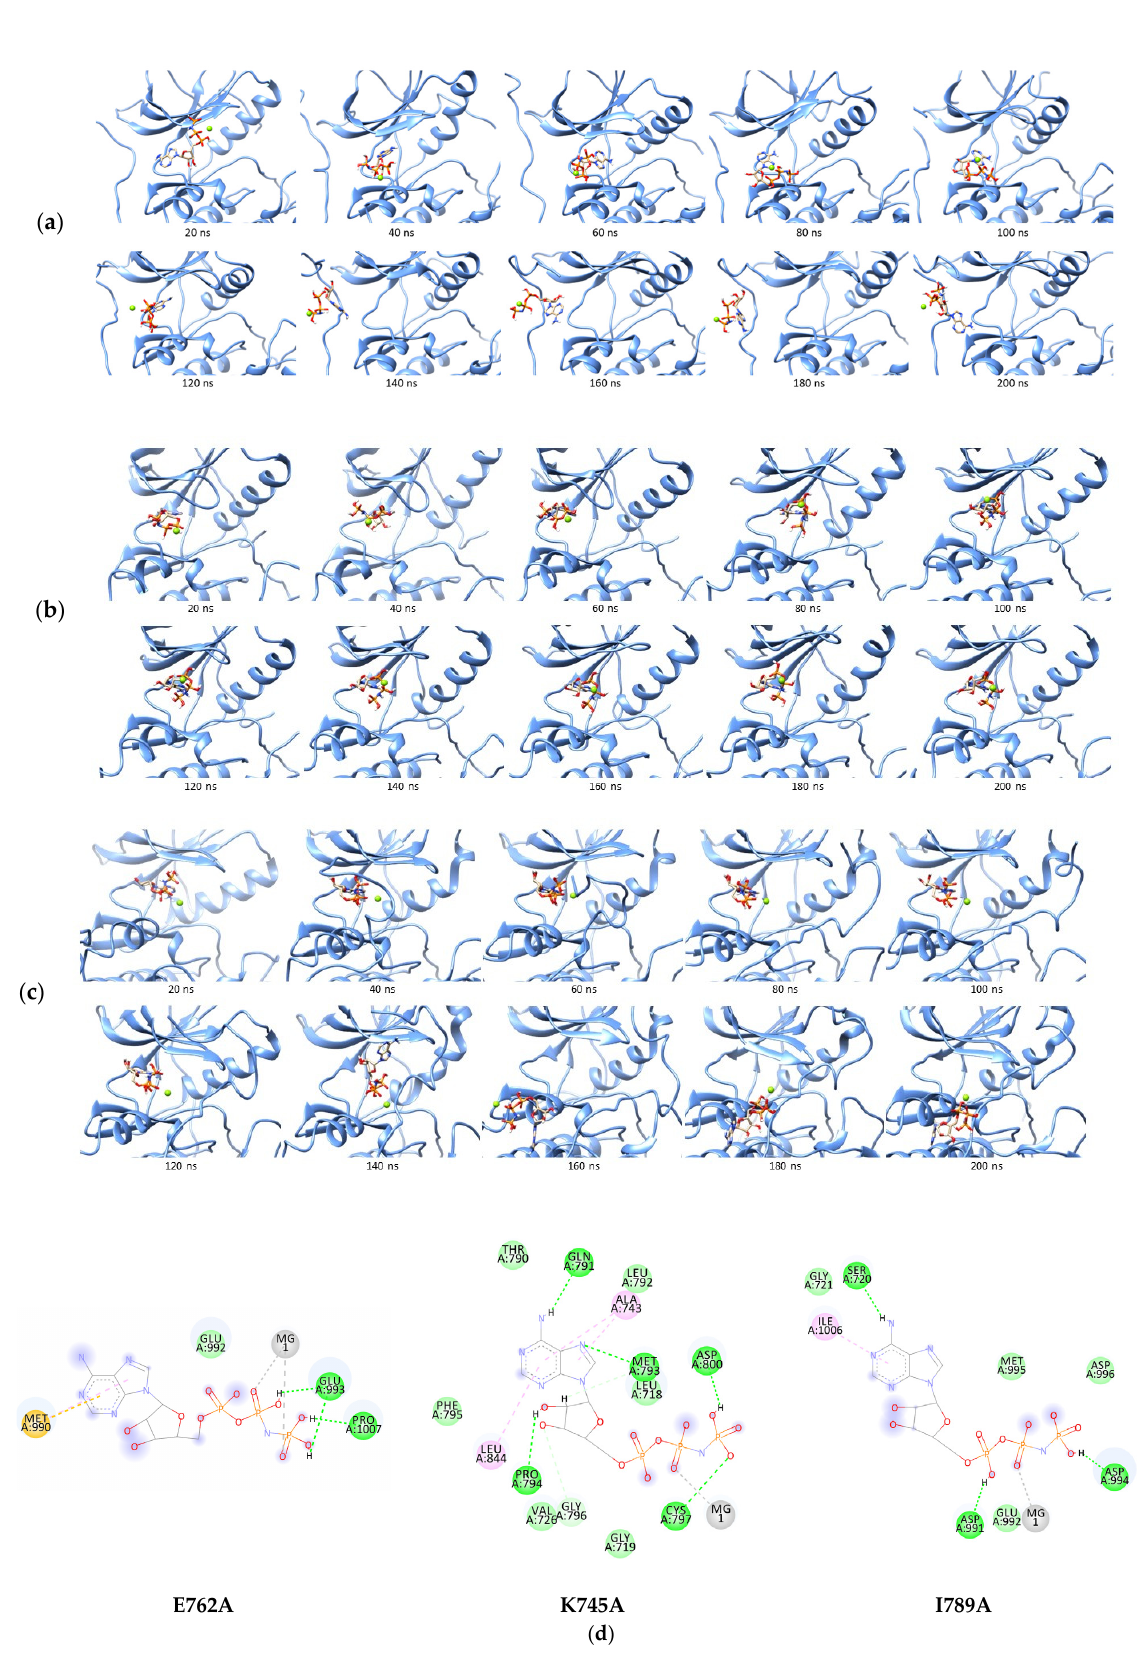
E762A K745A I789A ( d ) Figure 5. Trajectories of ANP during 200 ns simulation in the binding site of E762A ( a ), K745A ( b ), Figure 5. Trajectories of ANP during 200 ns simulation in the binding site of E762A ( a ), K745A ( b ), Figure 5. Trajectories of ANP during 200 ns simulation in the binding site of E762A ( a ), K745A ( b ), Figure 5. Trajectories of ANP during 200 ns simulation in the binding site of E762A ( a ), K745A ( b ), Figure 5. Trajectories of ANP during 200 ns simulation in the binding site of E762A ( a ), K745A ( b ), Figure 5. Trajectories of ANP during 200 ns simulation in the binding site of E762A ( a ), K745A ( b ), Figure 5. Trajectories of ANP during 200 ns simulation in the binding site of E762A ( a ), K745A ( b ), I789A ( c ), and ( d ) Two-dimensional interaction of ANP to the mutated receptor: , hydrogen bond; I789A ( c ), and ( d ) Two-dimensional interaction of ANP to the mutated receptor: , hydrogen bond; I789A ( c ), and ( d ) Two-dimensional interaction of ANP to the mutated receptor: , hydrogen bond; I789A ( c ), and ( d ) Two-dimensional interaction of ANP to the mutated receptor: , hydrogen bond; I789A ( c ), and ( d ) Two-dimensional interaction of ANP to the mutated receptor: , hydrogen bond; I789A ( c ), and ( d ) Two-dimensional interaction of ANP to the mutated receptor: , hydrogen bond; I789A ( c ), and ( d ) Two-dimensional interaction of ANP to the mutated receptor: , hydrogen bond; , van der Waals; , metal acceptor; , pi-sulfur; , pi-alkyl. , van der Waals; , metal acceptor; , pi-sulfur; , pi-alkyl. , van der Waals; , metal acceptor; , pi-sulfur; , pi-alkyl. , van der Waals; , metal acceptor; , pi-sulfur; , pi-alkyl. , van der Waals; , metal acceptor; , pi-sulfur; , pi-alkyl. , van der Waals; , metal acceptor; , pi-sulfur; , pi-alkyl. , van der Waals; , metal acceptor; , pi-sulfur; , On the other hand, eight single-mutations showed ΔΔ G to be more negative than On the other hand, eight single-mutations showed ΔΔ G to be more negative than On the other hand, eight single-mutations showed ΔΔ G to be more negative than On the other hand, eight single-mutations showed ΔΔ G to be more negative than On the other hand, eight single-mutations showed ΔΔ G to be more negative than ANP against wild-type EGFR, including G779A, Q791A, L792A, R841A, N842A, V843A, ANP against wild-type EGFR, including G779A, Q791A, L792A, R841A, N842A, V843A, ANP against wild-type EGFR, including G779A, Q791A, L792A, R841A, N842A, V843A, ANP against wild-type EGFR, including G779A, Q791A, L792A, R841A, N842A, V843A, ANP against wild-type EGFR, including G779A, Q791A, L792A, R841A, N842A, V843A, I853A, and D855A. The I853A complex with ANP showed the most negative binding en- I853A, and D855A. The I853A complex with ANP showed the most negative binding en- I853A, and D855A. The I853A complex with ANP showed the most negative binding en- I853A, and D855A. The I853A complex with ANP showed the most negative binding en- I853A, and D855A. The I853A complex with ANP showed the most negative binding en- ergy with ΔΔ G of − 9.4553 kcal/mol. During the mutation, ANP could bind stably and form ergy with ΔΔ G of − 9.4553 kcal/mol. During the mutation, ANP could bind stably and form hydrogen bonds to Ser720, Thr790, Gln791, Met793, Cys797, and Asp800 (Figure 6). More- ergy with ΔΔ G of − 9.4553 kcal/mol. During the mutation, ANP could bind stably and form ergy with ΔΔ G of − 9.4553 kcal/mol. During the mutation, ANP could bind stably and form ergy with ΔΔ G of − 9.4553 kcal/mol. During the mutation, ANP could bind stably and form ergy with ΔΔ G of − 9.4553 kcal/mol. During the mutation, ANP could bind stably and form over, G779A, the second most negative difference, showed similar results. ANP could oc- cupy the G779A binding pocket stably during simulation while maintaining the interac- tion between its adenine core and several pocket residues such as Thr790, Gln791, and Met793. The ribose group formed a hydrogen bond with Arg841 rather than interacting with Cys797 as in the ANP – I853A complex. The phosphate groups lost the hydrogen bond with Ser720 but were replaced by two new hydrogen bonds with Leu718 and Cys797 (Figure 6c). hydrogen bonds to Ser720, Thr790, Gln791, Met793, Cys797, and Asp800 (Figure 6). More- over, G779A, the second most negative difference, showed similar results. ANP could oc- cupy the G779A binding pocket stably during simulation while maintaining the interac- tion between its adenine core and several pocket residues such as Thr790, Gln791, and Met793. The ribose group formed a hydrogen bond with Arg841 rather than interacting with Cys797 as in the ANP – I853A complex. The phosphate groups lost the hydrogen bond with Ser720 but were replaced by two new hydrogen bonds with Leu718 and Cys797 (Figure 6c). hydrogen bonds to Ser720, Thr790, Gln791, Met793, Cys797, and Asp800 (Figure 6). More- over, G779A, the second most negative difference, showed similar results. ANP could oc- cupy the G779A binding pocket stably during simulation while maintaining the interac- tion between its adenine core and several pocket residues such as Thr790, Gln791, and Met793. The ribose group formed a hydrogen bond with Arg841 rather than interacting with Cys797 as in the ANP – I853A complex. The phosphate groups lost the hydrogen bond with Ser720 but were replaced by two new hydrogen bonds with Leu718 and Cys797 (Figure 6c). hydrogen bonds to Ser720, Thr790, Gln791, Met793, Cys797, and Asp800 (Figure 6). More- over, G779A, the second most negative difference, showed similar results. ANP could oc- cupy the G779A binding pocket stably during simulation while maintaining the interac- tion between its adenine core and several pocket residues such as Thr790, Gln791, and Met793. The ribose group formed a hydrogen bond with Arg841 rather than interacting with Cys797 as in the ANP – I853A complex. The phosphate groups lost the hydrogen bond with Ser720 but were replaced by two new hydrogen bonds with Leu718 and Cys797 (Figure 6c). hydrogen bonds to Ser720, Thr790, Gln791, Met793, Cys797, and Asp800 (Figure 6). More- over, G779A, the second most negative difference, showed similar results. ANP could oc- cupy the G779A binding pocket stably during simulation while maintaining the interac- tion between its adenine core and several pocket residues such as Thr790, Gln791, and Met793. The ribose group formed a hydrogen bond with Arg841 rather than interacting with Cys797 as in the ANP – I853A complex. The phosphate groups lost the hydrogen bond with Ser720 but were replaced by two new hydrogen bonds with Leu718 and Cys797 (Figure 6c). hydrogen bonds to Ser720, Thr790, Gln791, Met793, Cys797, and Asp800 (Figure 6). More- over, G779A, the second most negative difference, showed similar results. ANP could oc- cupy the G779A binding pocket stably during simulation while maintaining the interac- tion between its adenine core and several pocket residues such as Thr790, Gln791, and Met793. The ribose group formed a hydrogen bond with Arg841 rather than interacting with Cys797 as in the ANP – I853A complex. The phosphate groups lost the hydrogen bond with Ser720 but were replaced by two new hydrogen bonds with Leu718 and Cys797 (Figure 6c).